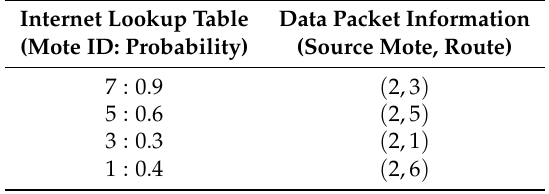
Table 2. Sample of a local routing table store in a random sensor. Please note that (Mote ID:Probability) is the routing forward data and (Source Mote, Route) is the routing backward